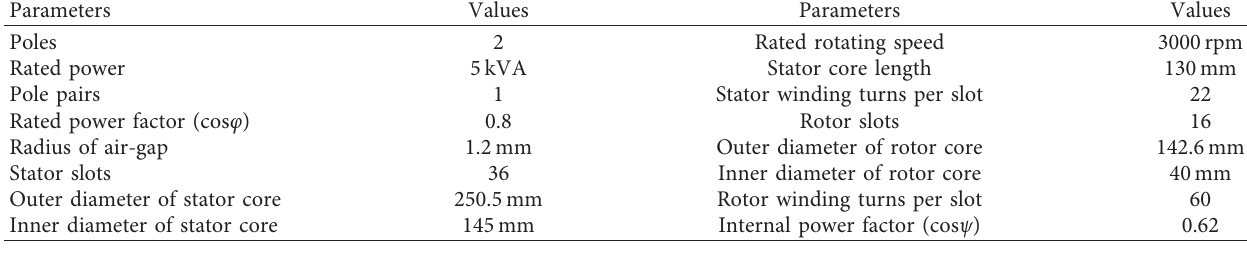
Table 2: Key parameters of CS-5 prototype